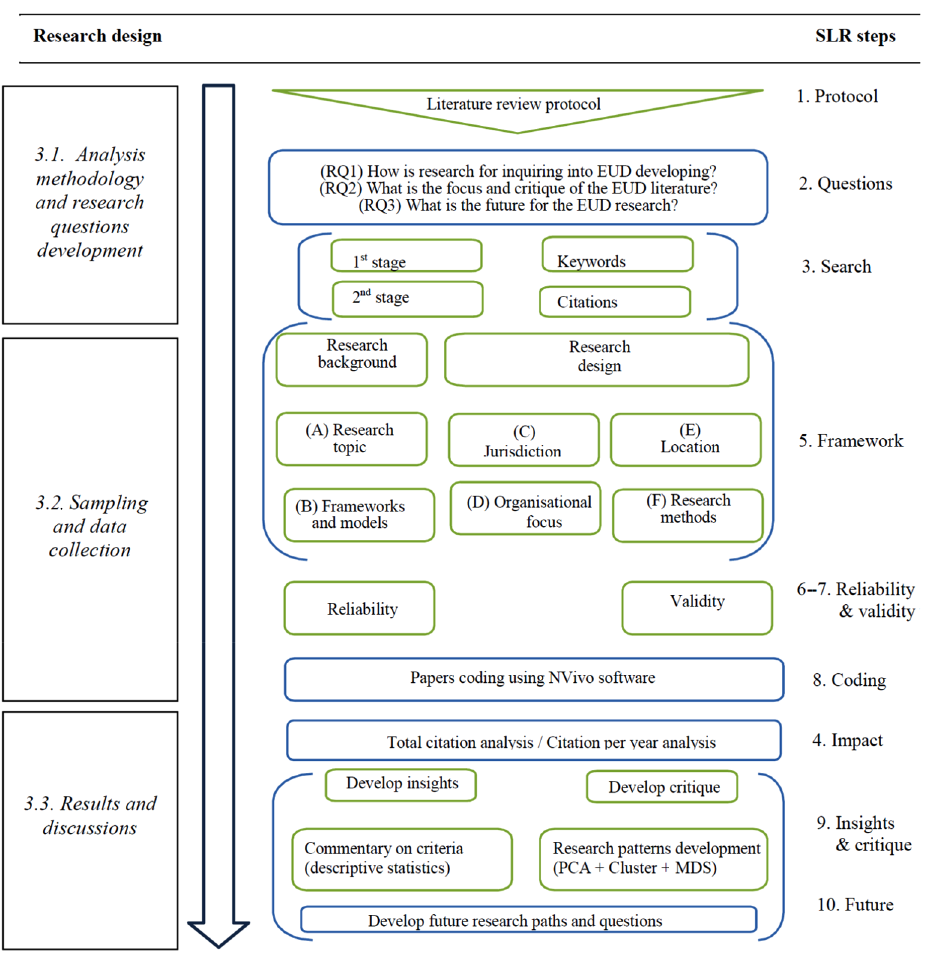
Figure 1. Designing research based on SLR